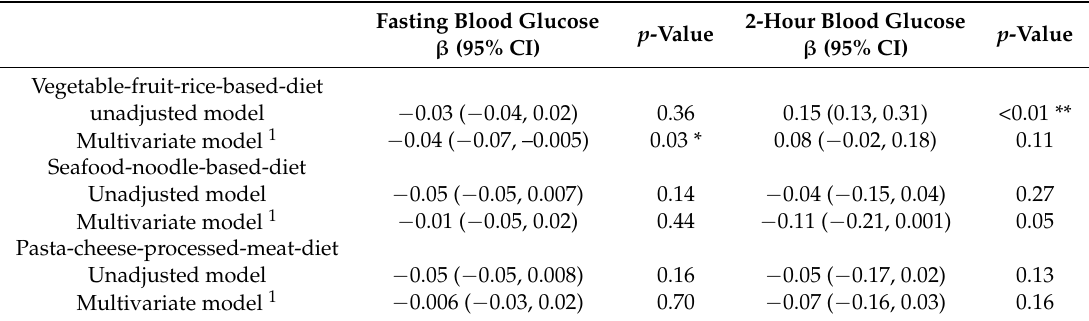
Table 4. Linear regression analysis of dietary patterns with fasting and 2-hour blood glucose levels following